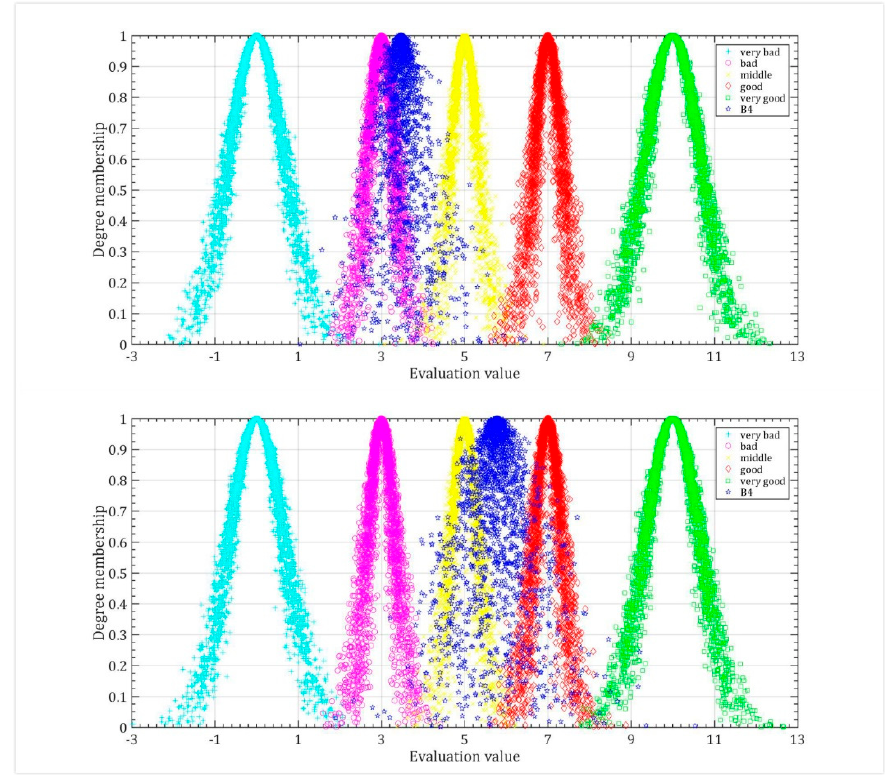
Figure 13. Cloud image of welfare evaluation grades of mental state of land-lost farmers' households under different livelihood assets .